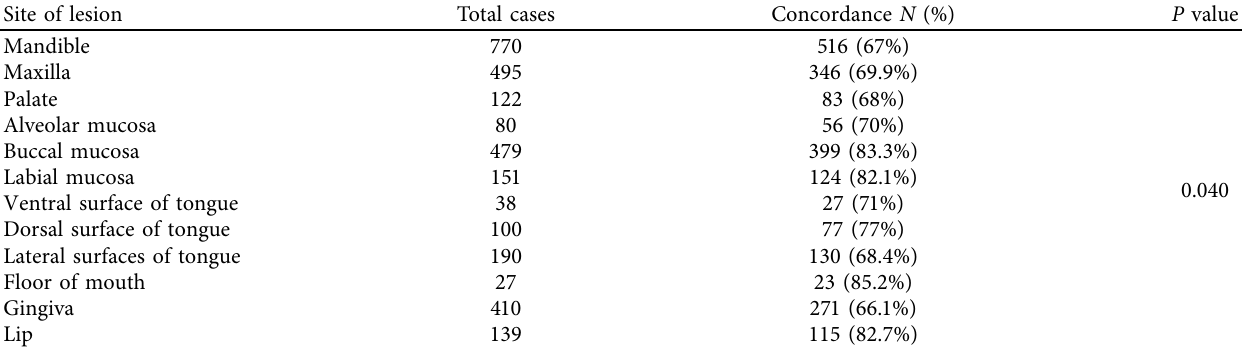
Table 2: Concordance rate of clinical and histopathologic diagnosis based on